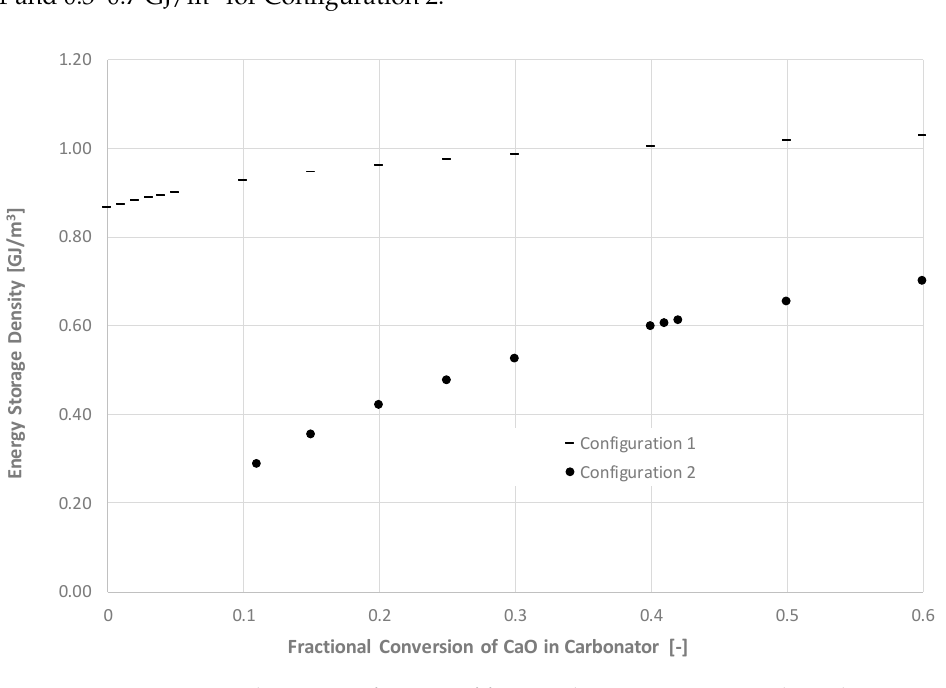
Figure 7. Energy storage density as a function of fractional CaO conversion in the carbonator.